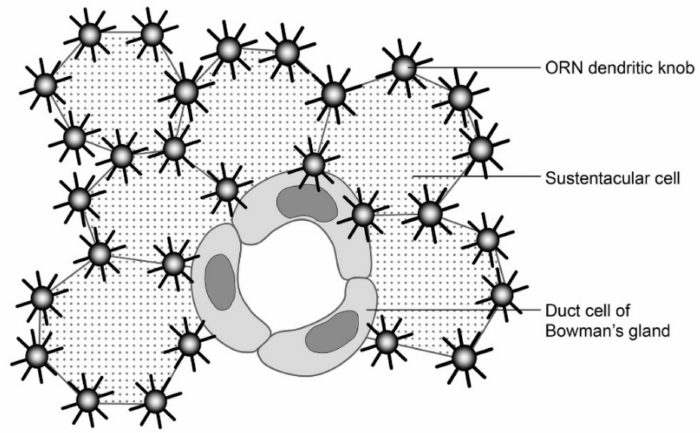
Figure 1. A schematic diagram illustrating major cell types and their relations on the tangential view